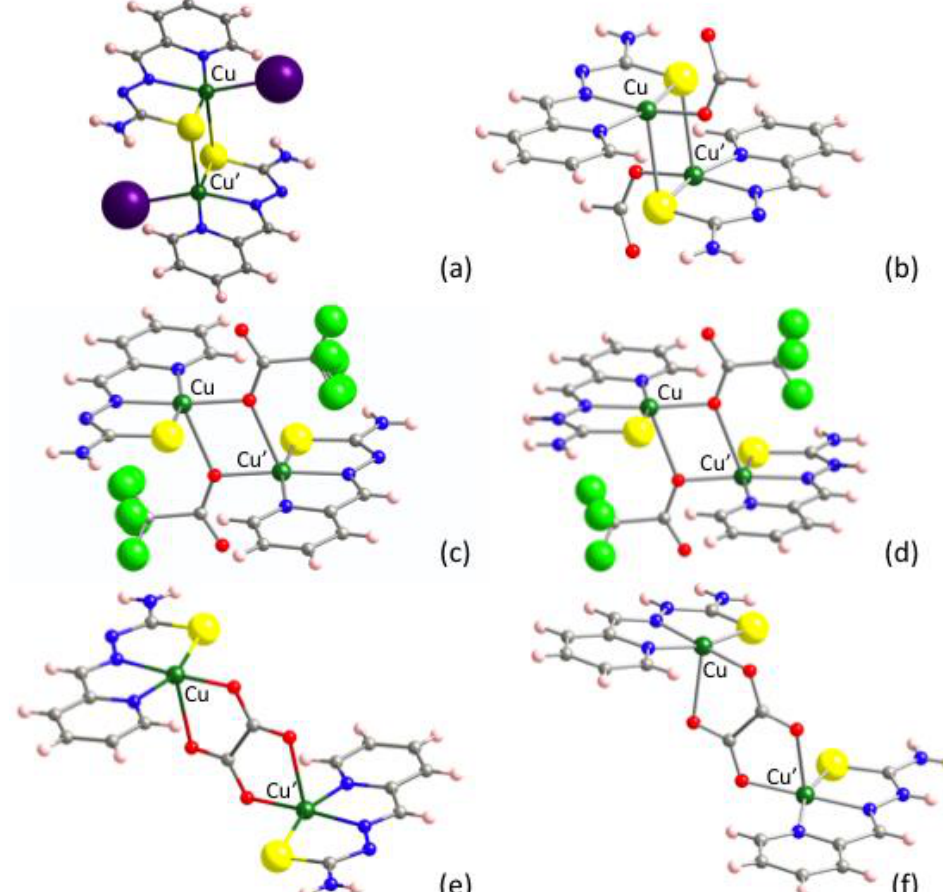
Figure 6. Molecular structures of the here explored complexes. ( a ) [{CuLI} 2 ] ( 2 ), ( b ) [{CuL(HCOO)} 2 ], ( c ) [{CuL(tfa)} 2 ], ( d ) [{Cu(HL)(tfa)} 2 ] 2+ dimers in [{Cu(HL)(tfa)} 2 ][tfa], ( e ) [{CuL} 2 (ox)] in [{CuL} 2 (ox)] · 2H 2 O and ( f ) [{Cu(HL)} 2 (ox)] 2+ dinuclear entities in [{Cu(HL)} 2 (ox)](NO 3 ) 2 . Table 5. Experimental (J exp ) and calculated (J calc ) J-values, H = − 2JS 1 S 2 , using the Broken Symmetry Approach of the Exchange Coupling Constants.